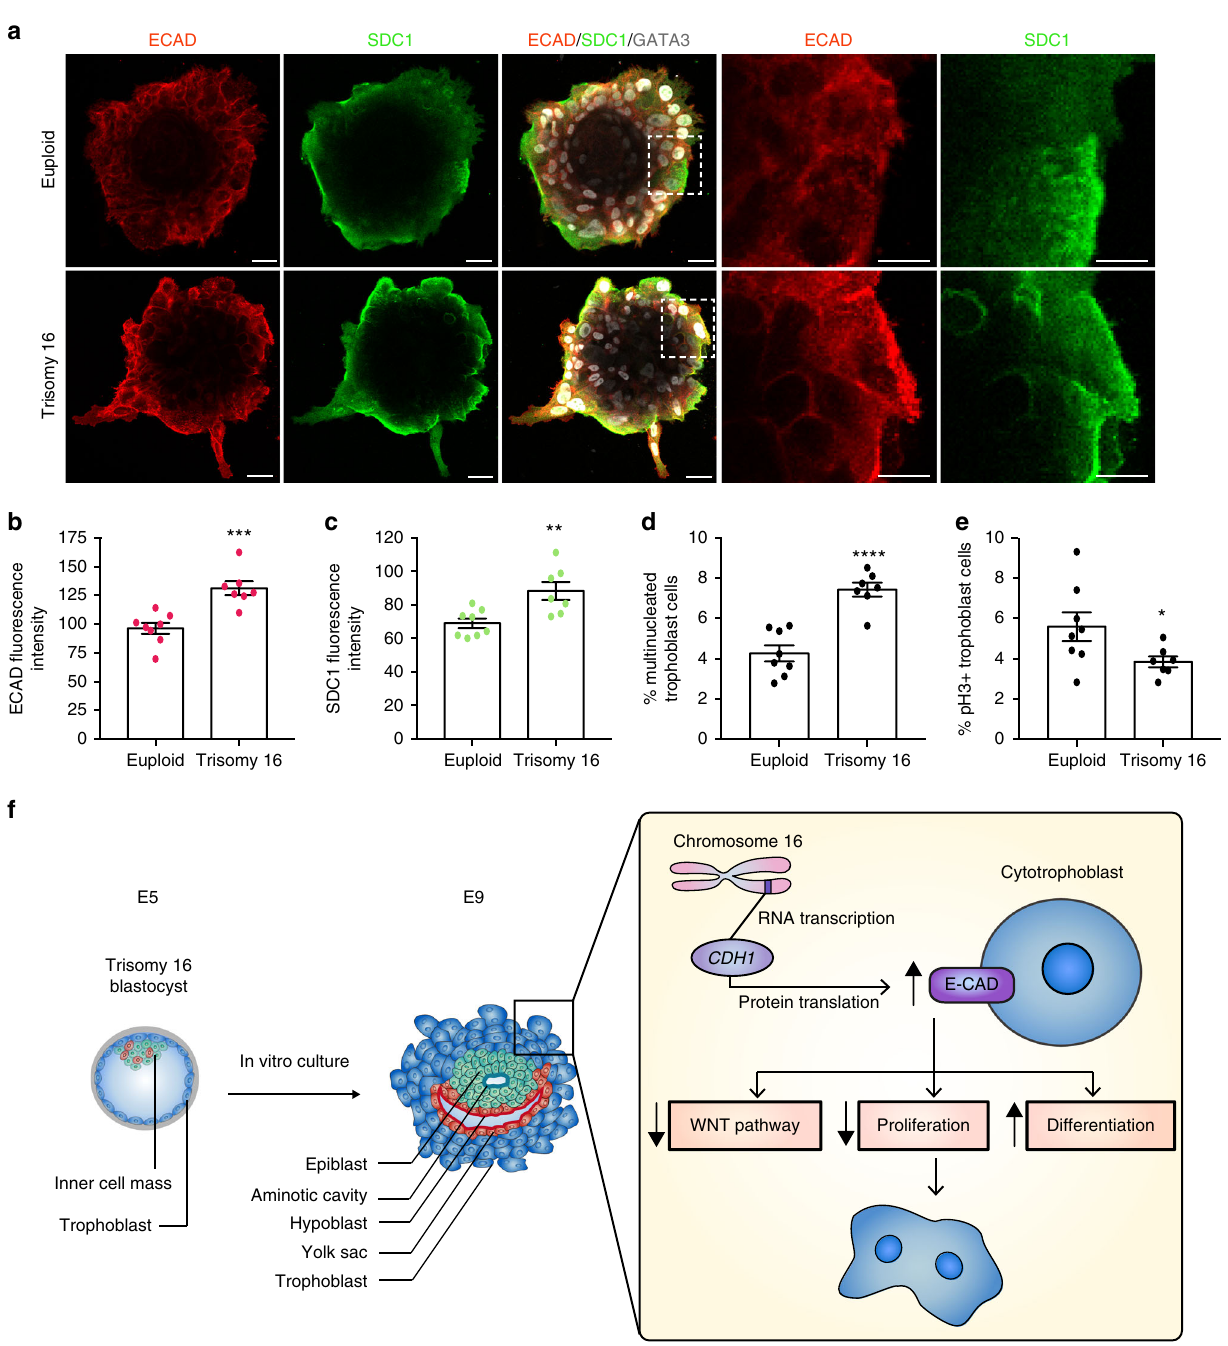
Fig. 6 Trophoblast characterization in trisomy 16 embryos. a Immunostaining of euploid and trisomy 16 embryos. Representative images of each karyotype are shown. Squares denote magni fi ed areas. Scale bars, 50 μ m. b , c Quanti fi cation of ECAD ( b ) and SDC1 ( c ) levels in embryos from panel ( a ). Each dot represents an individual embryo. n = 8 euploid and 7 trisomy 16 embryos. Unpaired Student ’ s t test, ** p = 0.0055, *** p = 0.0005. d Percentage of multinucleated trophoblast cells in embryos from panel ( a ). Each dot represents an individual embryo. n = 8 euploid and 7 trisomy 16 embryos. Unpaired Student ’ s t test, **** p < 0.0001. e Percentage of phospho-HISTONE H3 (pH3) positive cells in embryos from panel ( a ). Each dot represents an individual embryo. n = 8 euploid and 7 trisomy 16 embryos. Unpaired Student ’ s t test, * p = 0.0474. f Mechanistic model of trisomy 16 embryo development beyond the blastocyst stage. All error bars represent s.e.m. Source data are provided as a Source Data fi